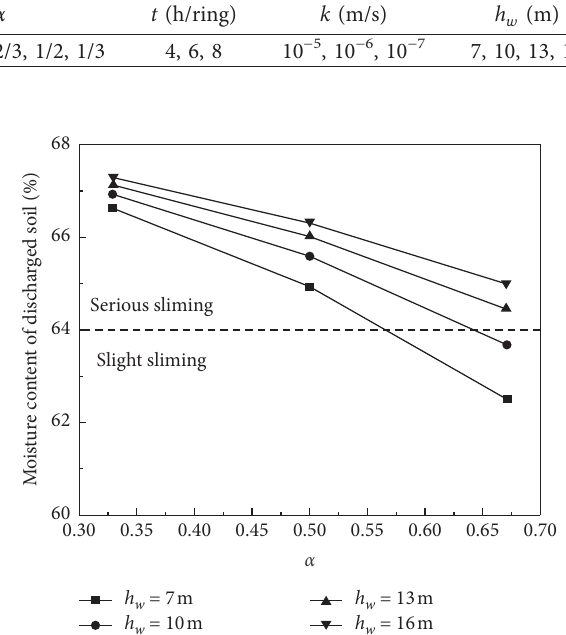
Figure 11: Influence of α on the moisture content of chamber soil when k � 10 − 5 m/s and t � 4h/ring.